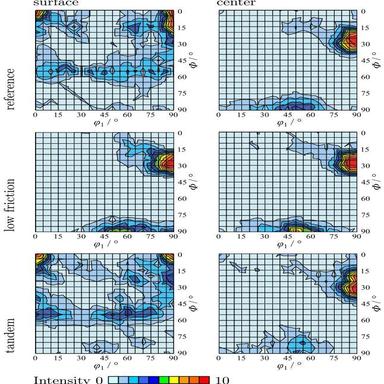
Influence of rolling conditions on the final rolling texture shown in terms of Orientation Distribution Function (ODF) sections at = ° 45 2 . Figure adopted from.